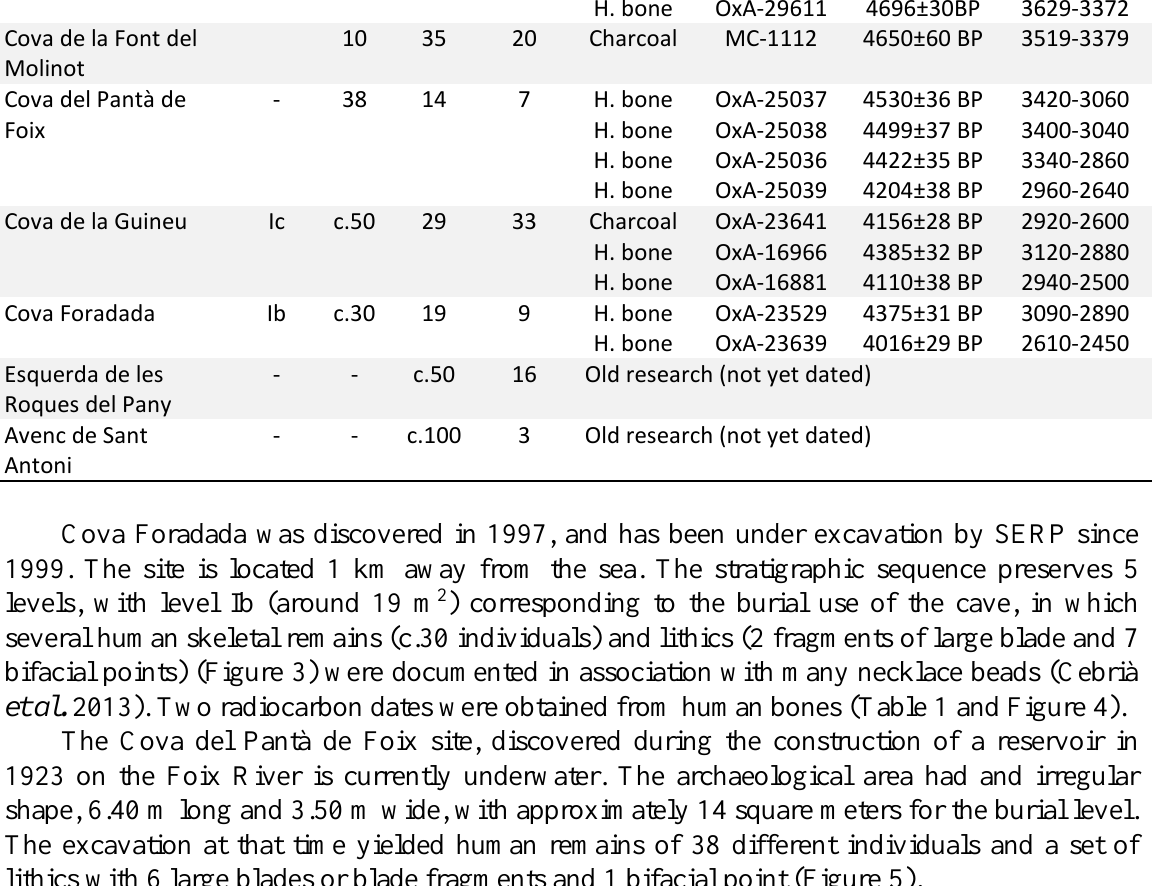
Table 1. NMI, lithic set and radiocarbon dates from analysed sites. Site Layer NMI Cova de